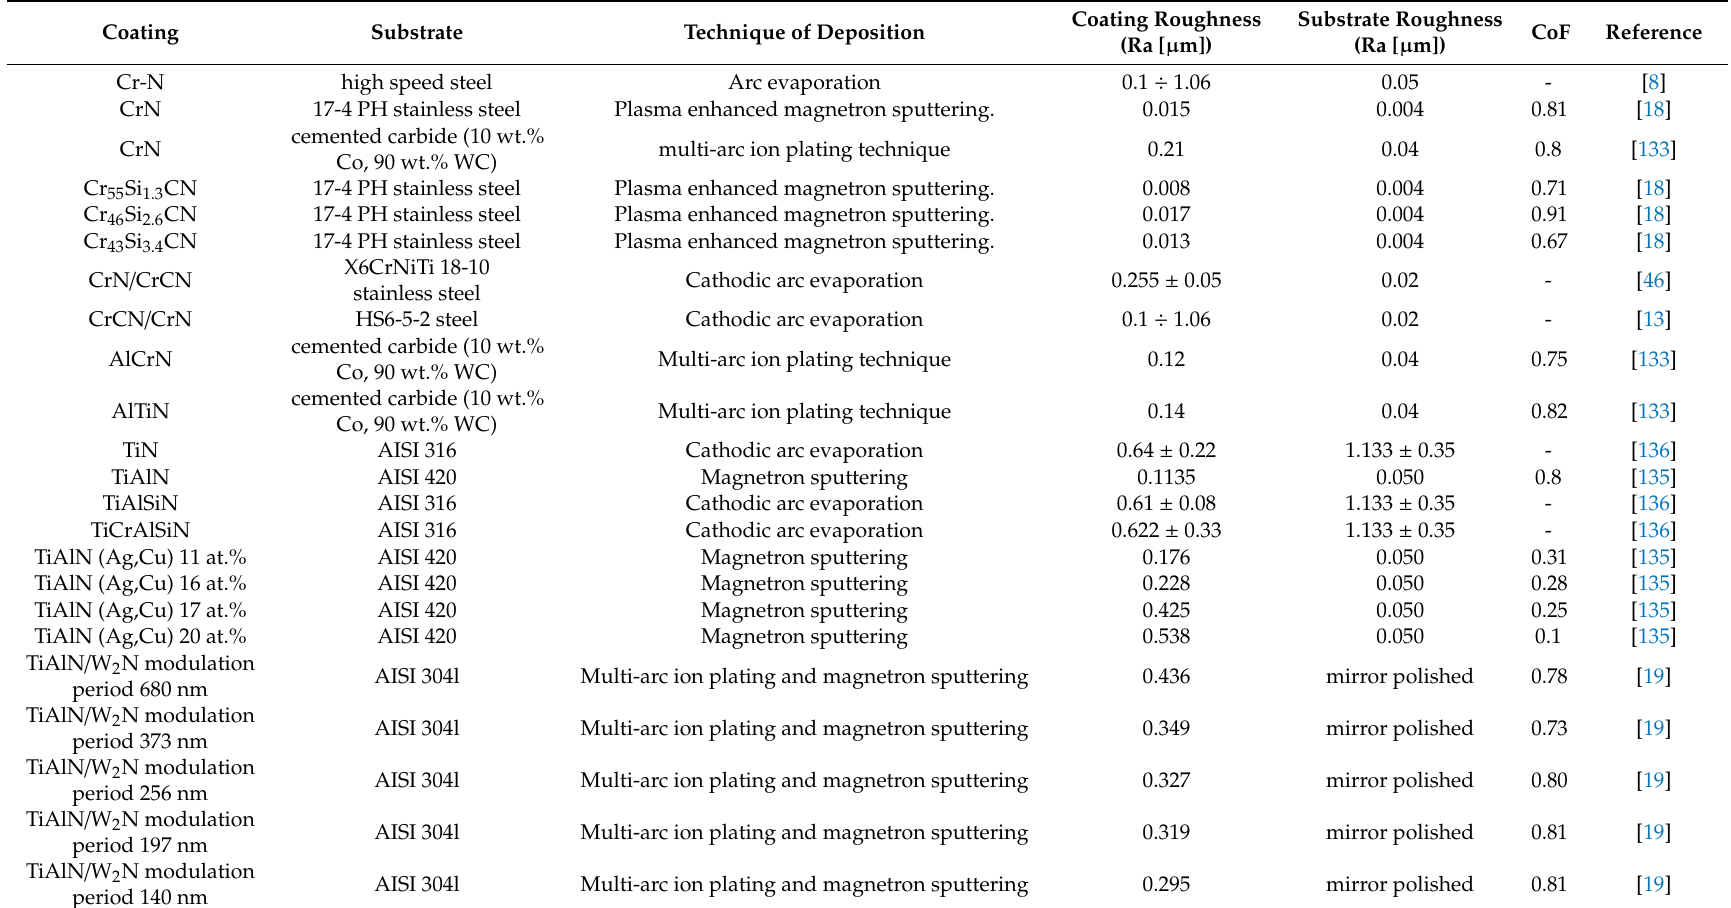
Table 1. Surface roughness and CoF of PVD